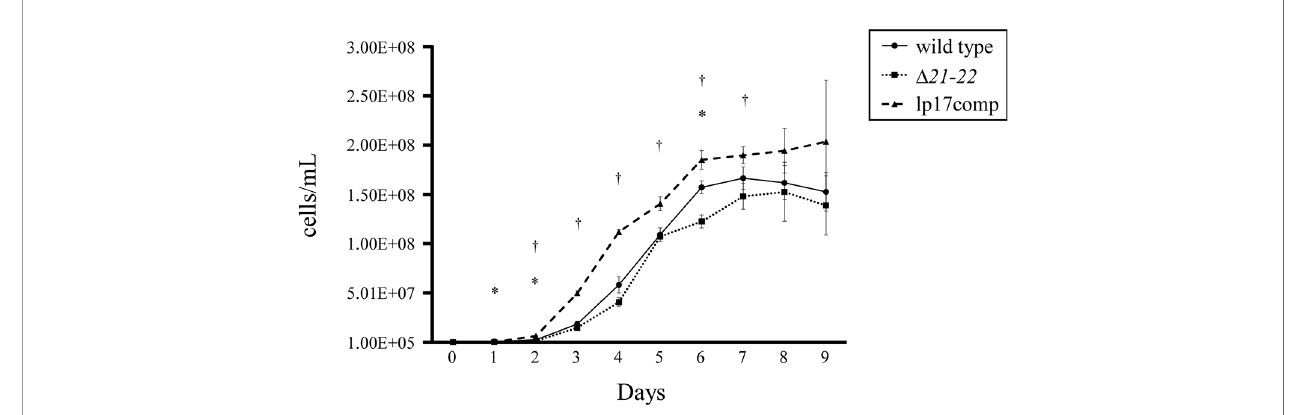
FIGURE 2 | Deletion of bbd21-bbd22 leads to decreased growth rate in vitro . At 24-h intervals, data points represent the average of cells/ml from three experiments, and error bars represent standard deviation. *wild type vs. D 21-22 , † wild type vs. lp17comp; p<0.05 (Student ’ s